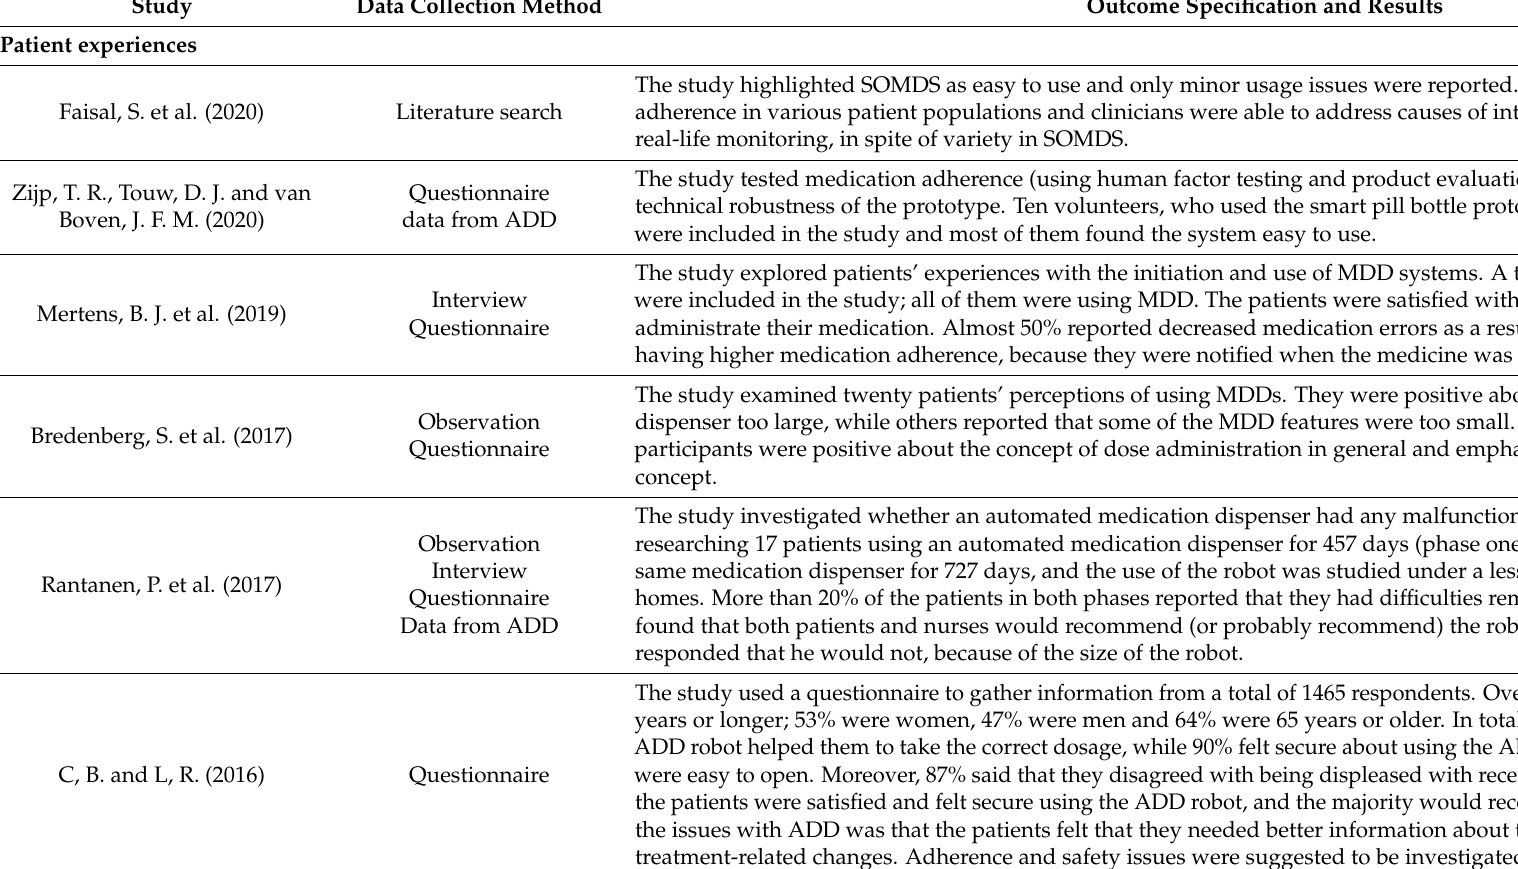
Table 2. Outcome specification and description of results from included studies (N =